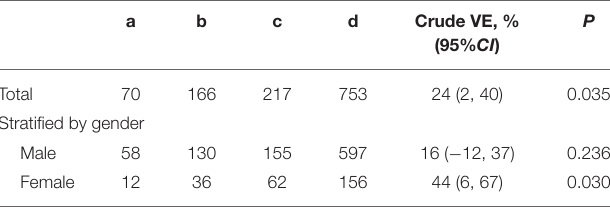
TABLE 2 | Unadjusted VE of PPV23 vaccination against pneumococcal diseases among people aged 60 years or older. a b